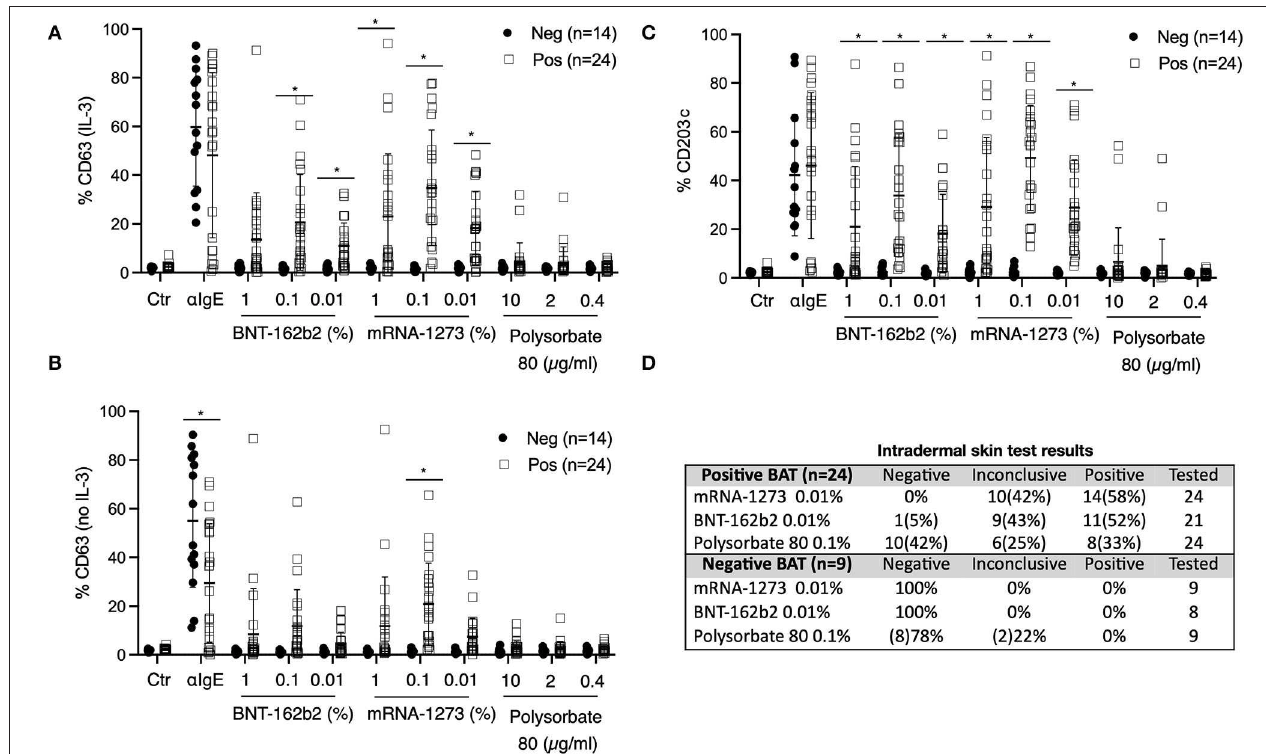
FIGURE 3 | Basophil activation tests (BAT). (A–C) Percentage of CD63 and CD203c expression after gating on CCR3 + basophils. A total 27 of BATs were interpreted as positive and 17 as negative for sensitization to COVID-19 mRNA vaccines. (A) Peripheral blood was incubated with IL-3 and different concentrations of COVID-19 mRNA vaccines or polysorbate-80. Anti-IgE antibodies were used as positive control and medium-only as a negative control. The percentage of CD63 expression is shown. (B) Peripheral blood was incubated with different concentrations of COVID-19 mRNA vaccines or polysorbate-80 without IL-3. CD63 expression is shown. (C) Peripheral blood was incubated with different concentrations of COVID-19 mRNA vaccines or polysorbate-80. CD203c expression is shown. (A–C) Anti-IgE antibodies were used as positive control and medium-only as a negative control. (D) Correlation of BAT results with skin test results (when available). Multiple unpaired T -test was performed. Mean and standard deviation are shown. * p < 0.05. Neg, negative; Pos,